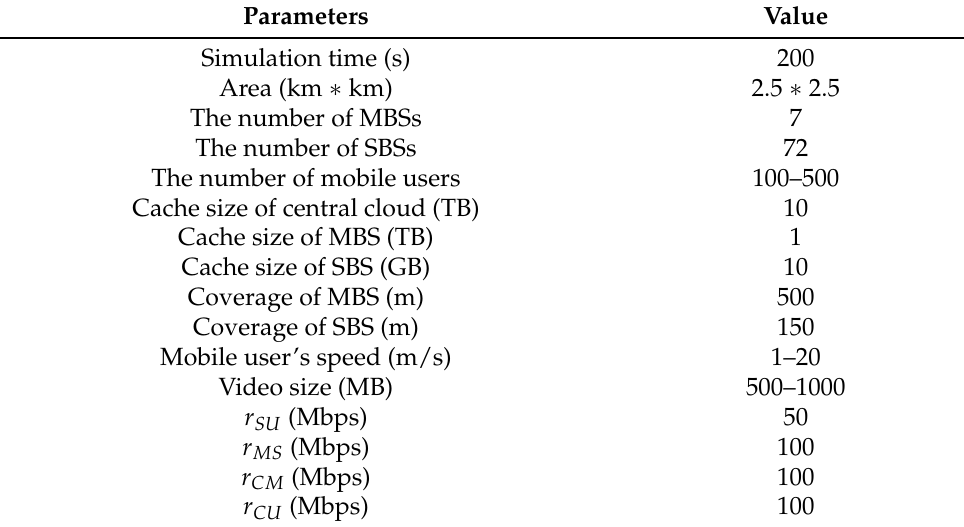
Table 1. Simulation